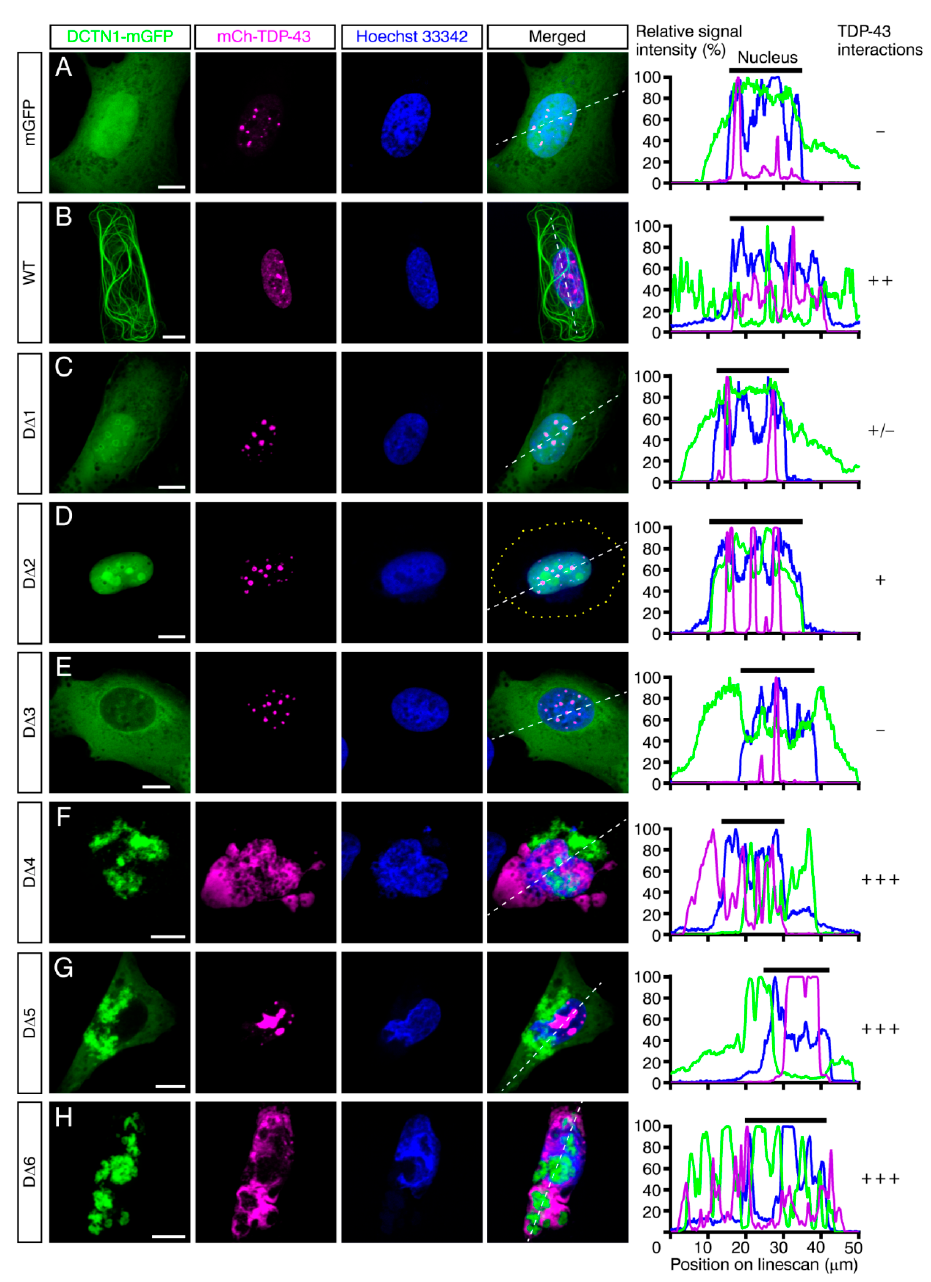
Figure 4. Truncated mutant forms of DCTN1 that contain the dynactin domain or C-terminal region cause TDP-43 mislocalization and aggregation. Maximum-intensity projections of deconvoluted z-stack confocal images of U2OS cells that coexpressed mGFP ( A ), wild-type (WT) ( B ) or mutant ( C–H ) DCTN1-mGFP and mCherry-tagged WT TDP-43 are shown. The transfected cells were cultured for three days under nonstressed conditions, fixed, and subjected to confocal microscopy. Scale bars, 10 μ m. The graphs show linescans of the cells along the white broken lines. The intensity of interactions between mutant DCTN1 and TDP-43, based on coimmunoprecipitation in Figure 2B, is shown on the right.